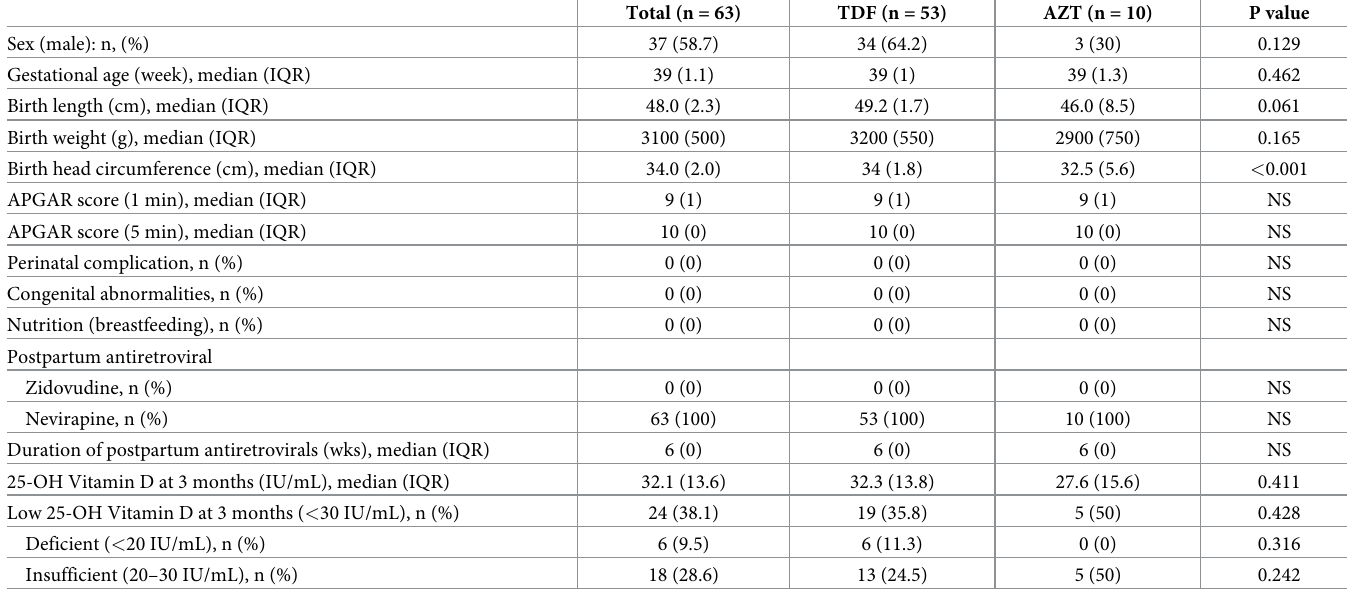
Table 2. Baseline clinical characteristics of the study